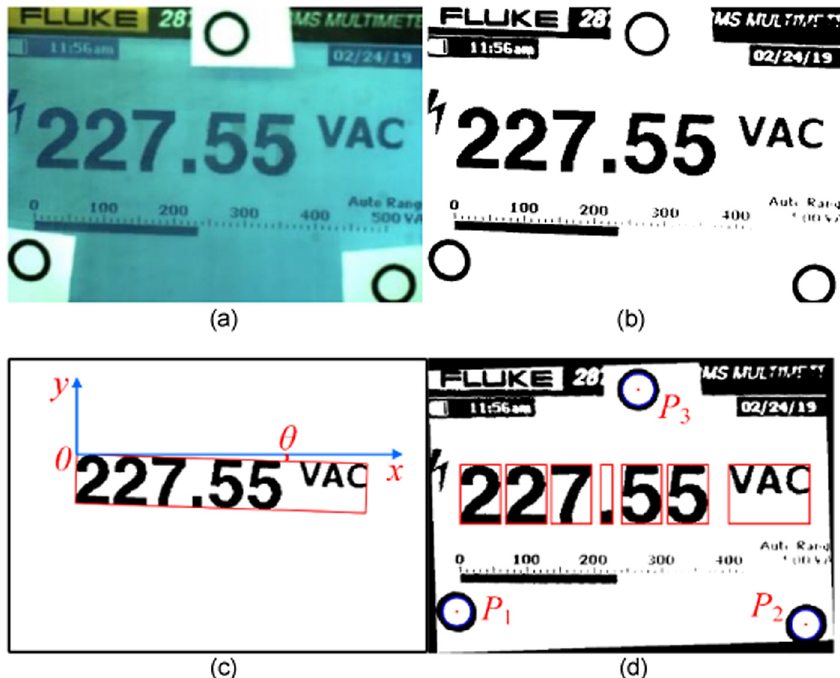
Figure 5: Label preparation phase. ( a ) Original image, ( b ) binary graph, ( c ) calculate rotation angle, and ( d ) location of each character.